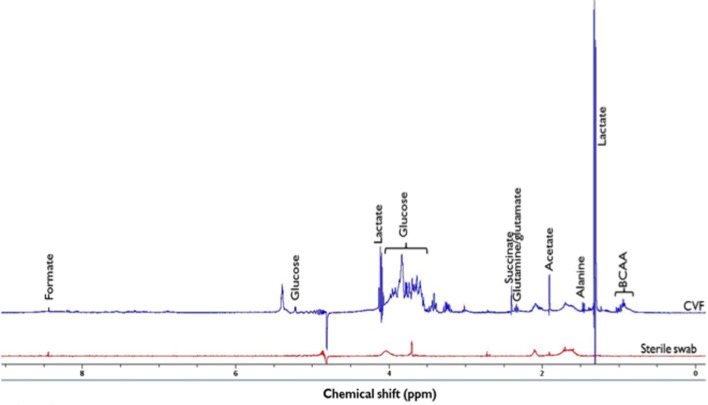
1H-NMR spectrum of identified metabolites in cervicovaginal fluid (CVF) and sterile swab at 400 MHz and 294 K. Due to the presence of other additional metabolite peaks at the δ = 3.2 ppm and 3.9 ppm region, the glucose signal at δ = 5.2 ppm was integrated and used in subsequent analysis. BCAA, Branched chain amino acids (leucine, isoleucine, and valine) (δ = 0.9–1.2 ppm), ppm, parts per million.